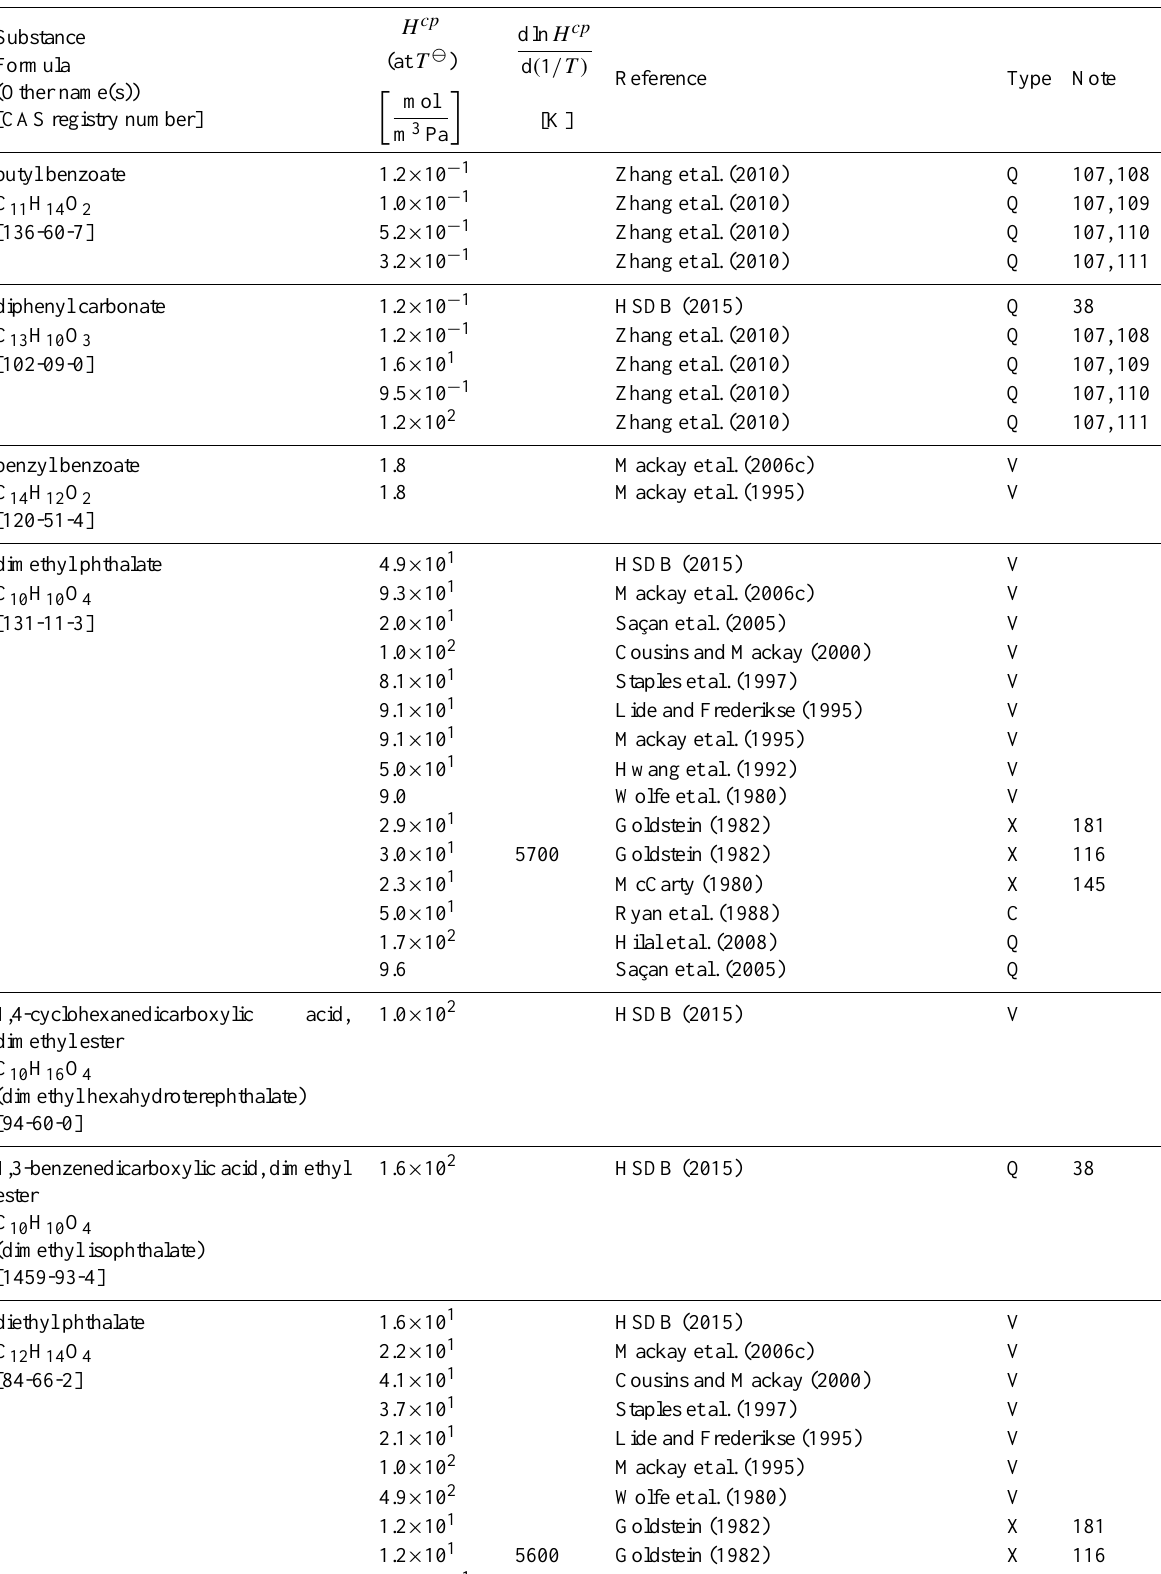
Table 6: Henry’s law constants for water as solvent